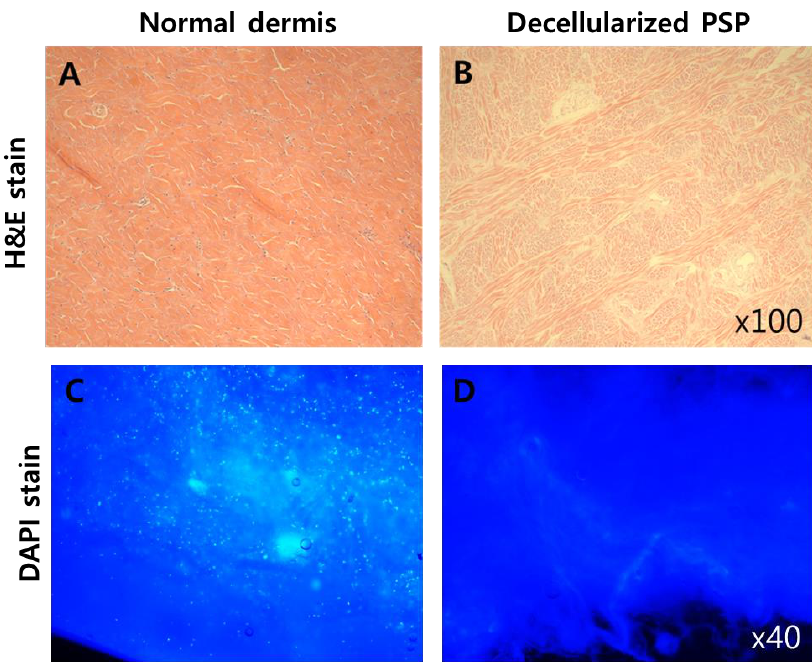
Figure 1. Qualitative analysis of decellularized porcine skin powder (PSP). Hematoxylin and eosin (H&E) ( A , B ) and diamidino-2-phenylindole (DAPI) stains ( C , D ) show the preserved extracellular matrix (ECM) without cells (nucleus).